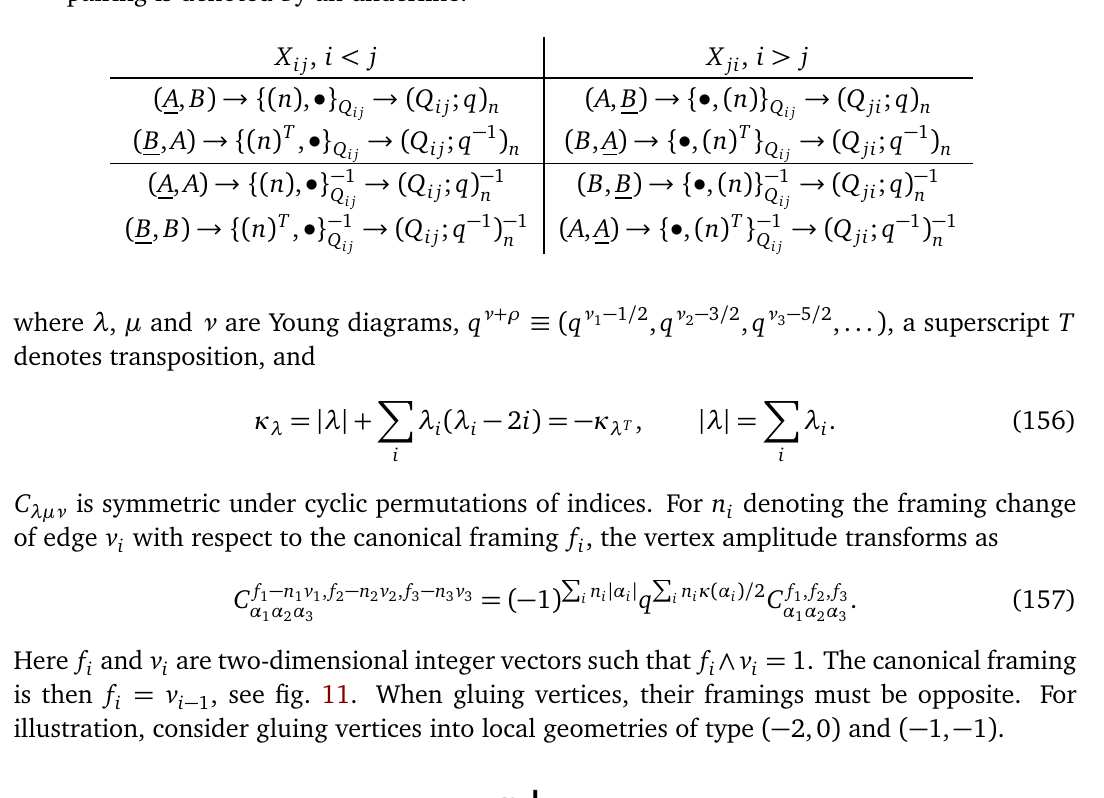
Table 2: The rules for assigning the contribution X function in a strip geometry with a single brane placed on the vertical external leg of the i -th vertex and in symmetric representation n . A position of the brane in the pairing is denoted by an underline.